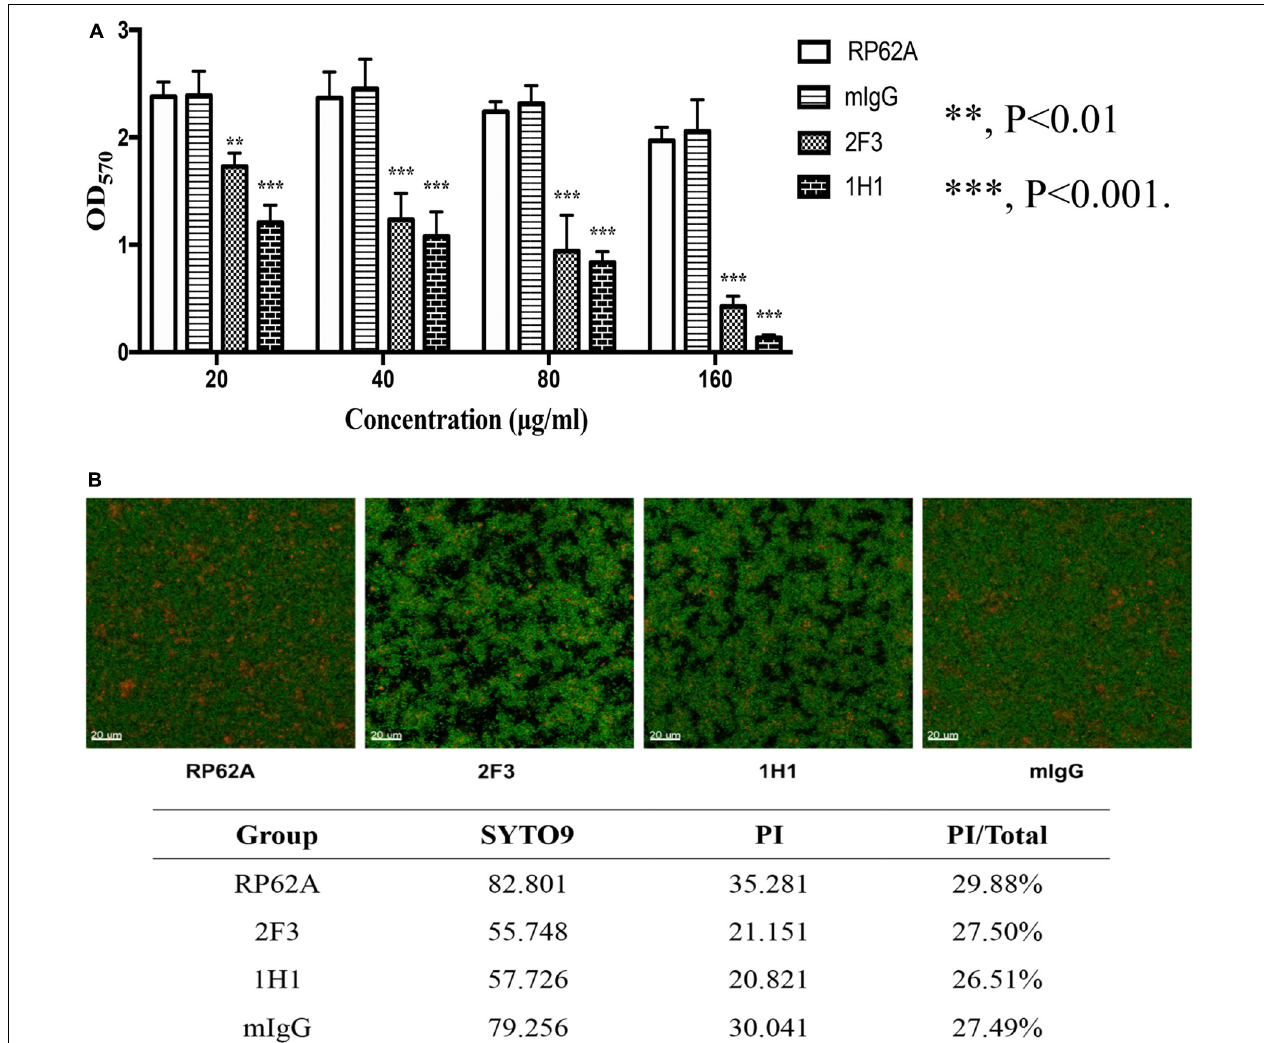
FIGURE 1 | Effects of YycG ex mAbs on the biofilm formation of S. epidermidis RP62A. (A) Inhibition of biofilm formation by YycG ex mAbs was detected using a microtiter plate assay. S. epidermidis RP62A was incubated with twofold serial dilutions of YycG ex mAbs (160–20 µ g/mL) at 37 ◦ C for 24 h. Biofilms were stained with 2% (w/v) crystal violet and the OD 570 was read. Statistical analyses were performed using Student’s t -test. (B) Effect of YycG ex mAbs on biofilm morphology of S. epidermidis RP62A, examined using CLSM. S. epidermidis RP62A was incubated with 80 µ g/mL YycG ex mAbs at 37 ◦ C for 24 h. Viable and dead cells fluoresced green and red, respectively. PI/Total values indicated the proportion of dead cells within the biofilms. RP62A, untreated; mIgG, normal mouse IgG treated.